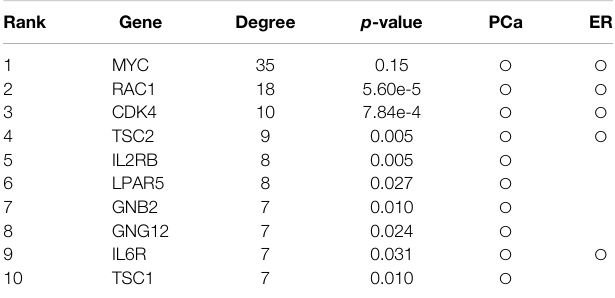
TABLE 2 | Top-10 hub genes in the estimated differential gene network between enzalutamide-resistant and enzalutamide-naive